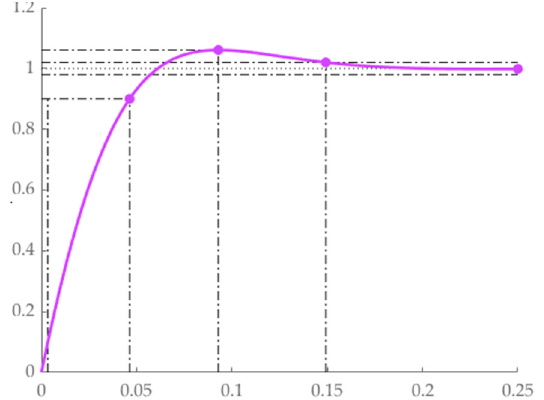
Figure 8. Unit step response of the Kv10.1 model in a control loop.